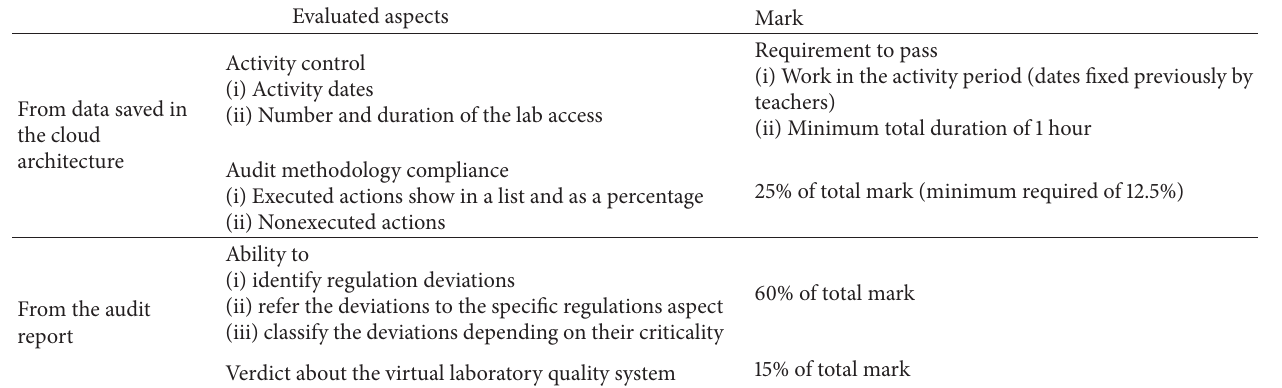
Table 2: Evaluation of the training performed in Usalpharma